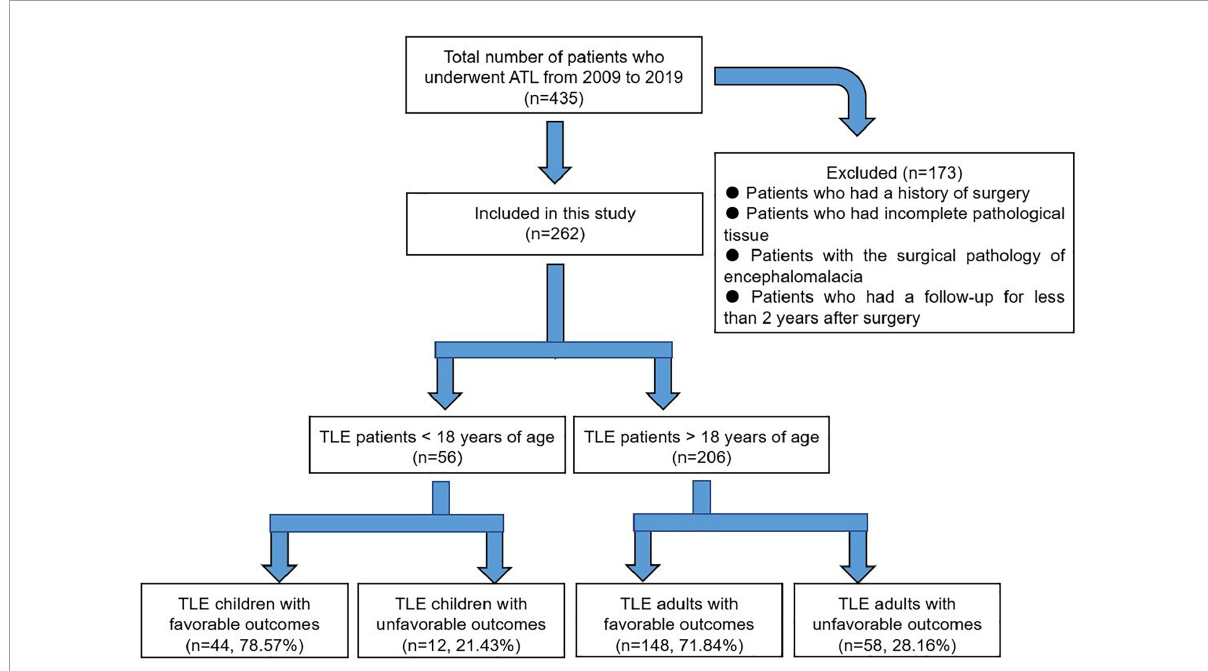
FIGURE1 Outline of the study design and summary of outcomes. Favorable outcomes: patients with Engel class I during the last 2 years of follow-up; unfavorable outcomes: patients with Engel class II–IV during the last 2 years of follow-up.